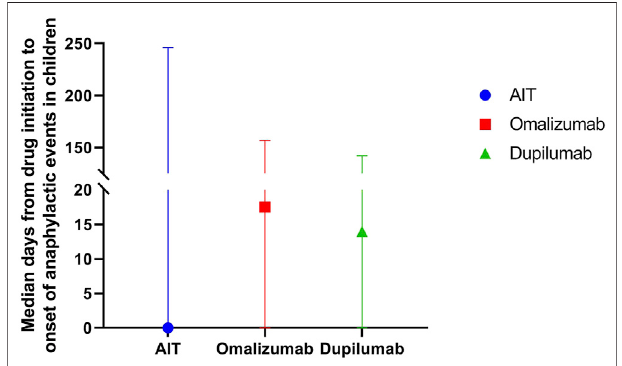
FIGURE 3 | Median days (IQR) from drug initiation to onset of anaphylactic symptoms of AIT, omalizumab, and dupilumab in children.